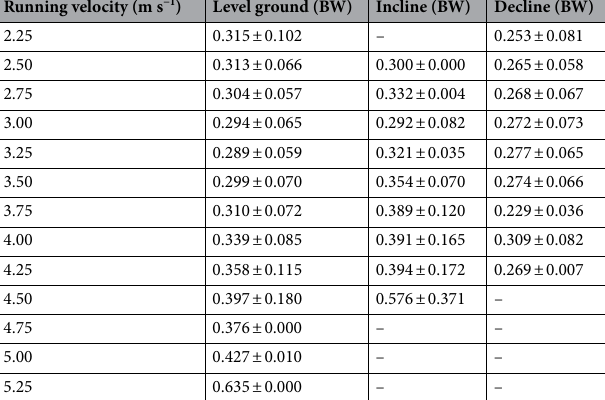
Table 4. BD-LSTM stance phase ground reaction force waveform